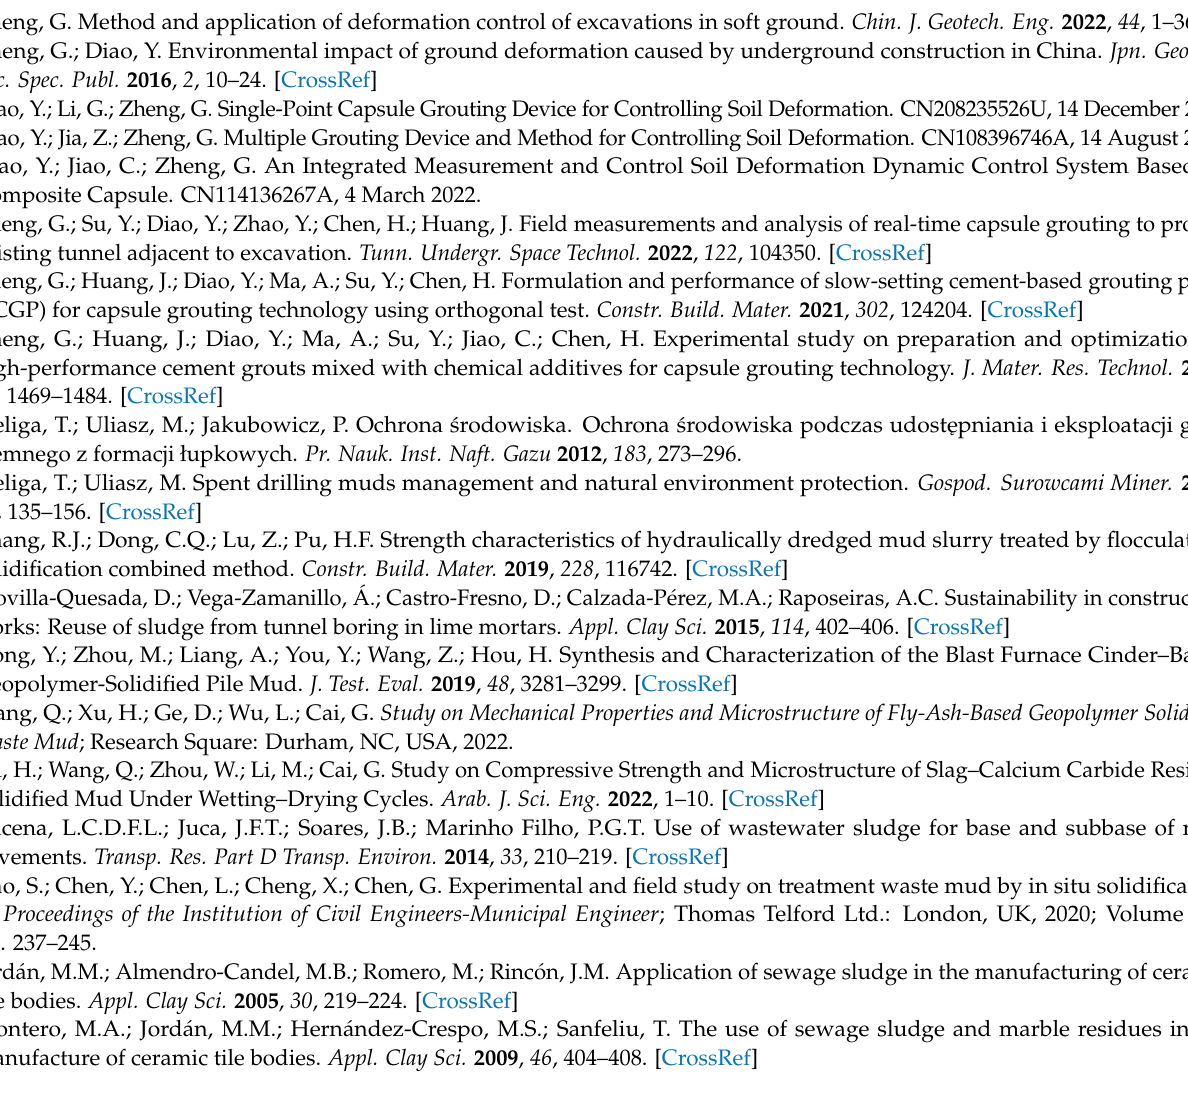
Table S4: Results of fitted optimal